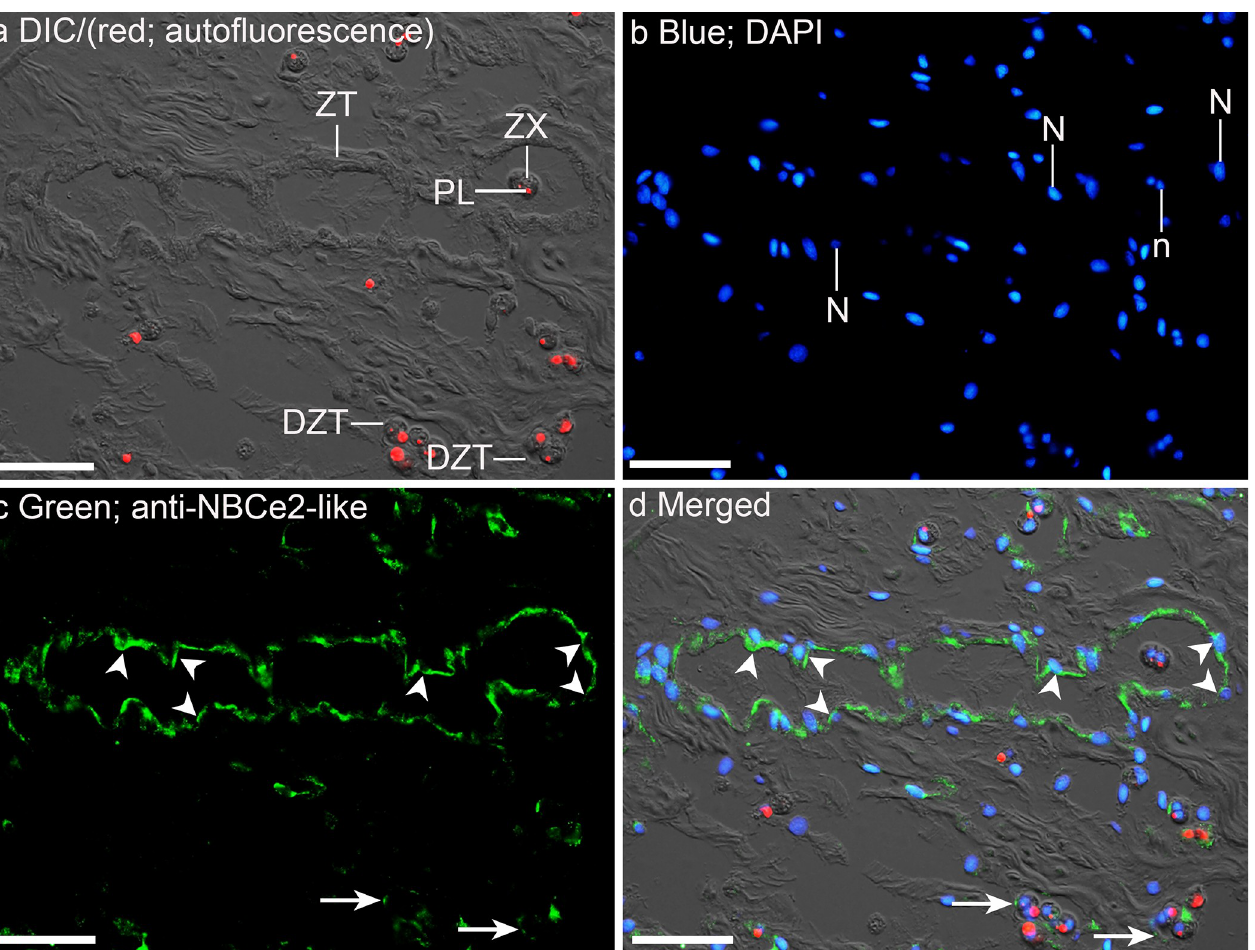
Fig 4. Immunofluorescence localization of a homolog of electrogenic Na + -HCO 3 − cotransporter 2 (NBCe2-like protein) in the outer mantle of Tridacna squamosa exposed to light for 12 h (a to d). (a) A differential interference contrast image (DIC) showing the structures of zooxanthellal tubules (ZTs) and disrupted zooxanthellal tubules (DZTs) overlaid with the red channel showing autofluorescence of the plastids (PLs) of the symbiont dinoflagellates (zooxanthellae, ZX) in red. (b) Nuclei stained with DAPI in blue, whereby n represents the round nucleus of symbionts and N represents the elongated nucleus of ZTs, (c) NBCe2-like-immunofluorescence is displayed in green. (d) The DIC image is merged with the red, blue and green channels. Arrowheads in (c, d) indicate the apical staining (with reference to the position of the elongated nucleus) of NBCe2-like in the membrane of the epithelial cells of ZTs surrouding the ZX in the outer mantle. Arrowheads with tail in (c, d) indicate the faint NBCe2-like-immunolabeling of DZTs. HL, hemolymph. Scale bar: 20 μ m. Reproducible results were obtained from three clams exposed to